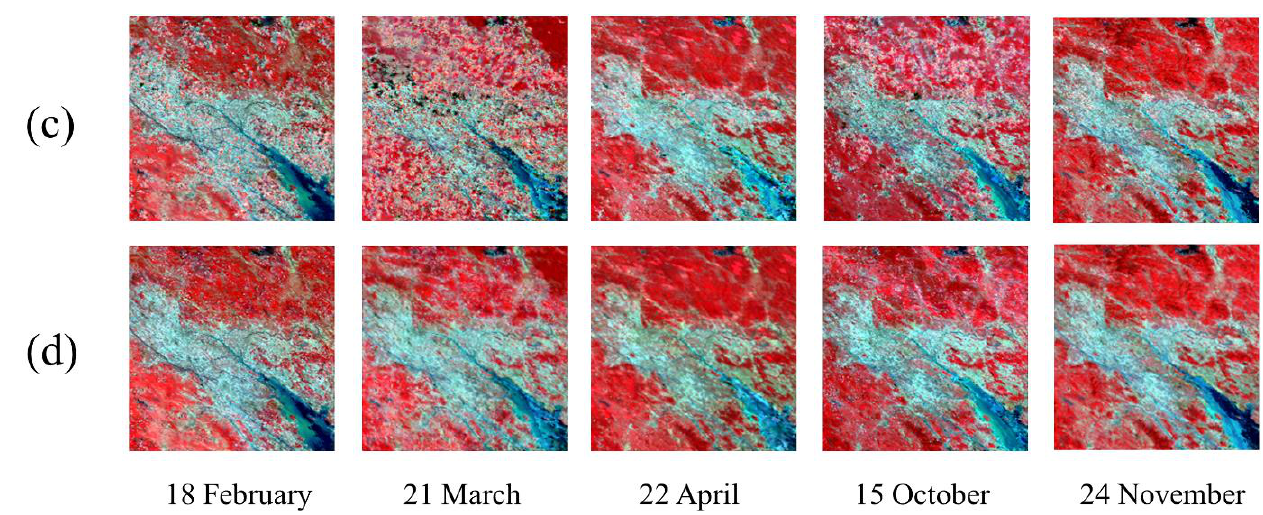
Figure 11. Recovery results of time series images based on different methods. ( a ) Original images. ( b ) Quality detection (The black parts are cloudy areas and the white parts are cloud-free areas). ( c ) Results of Zhang’s method. ( d ) Results of the CSTG method. The original images were acquired in 2020.